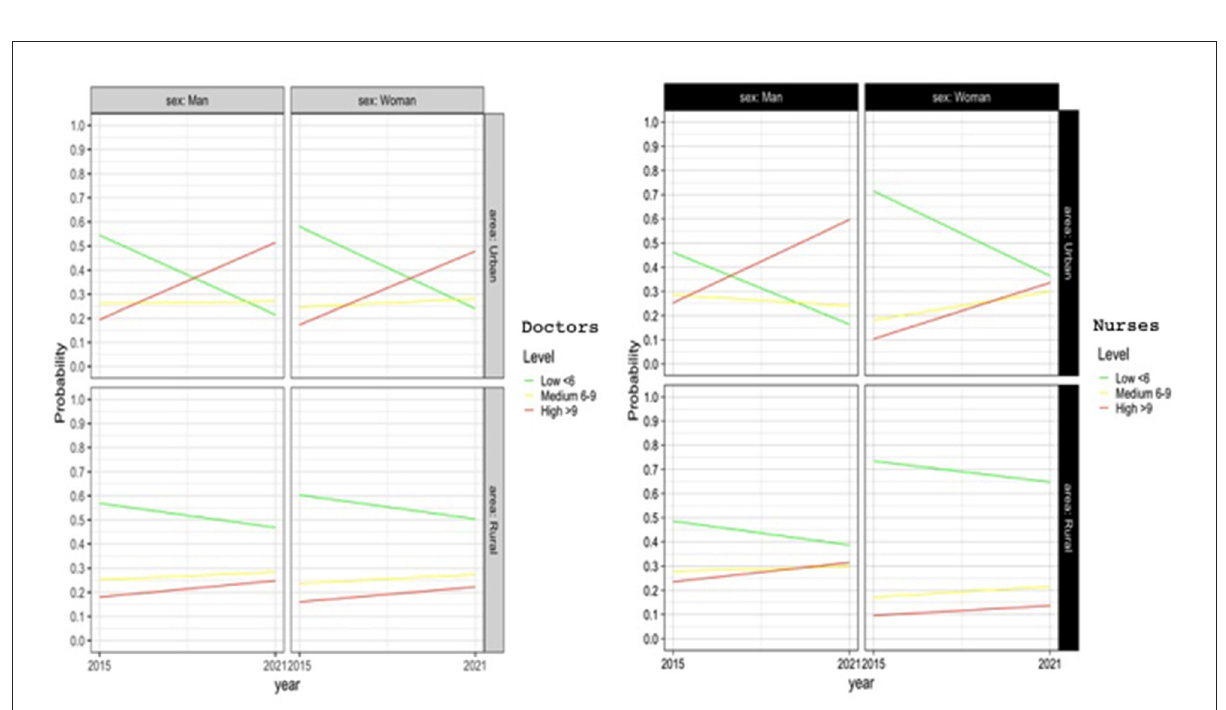
FIGURE3 Logistic regression model for professional